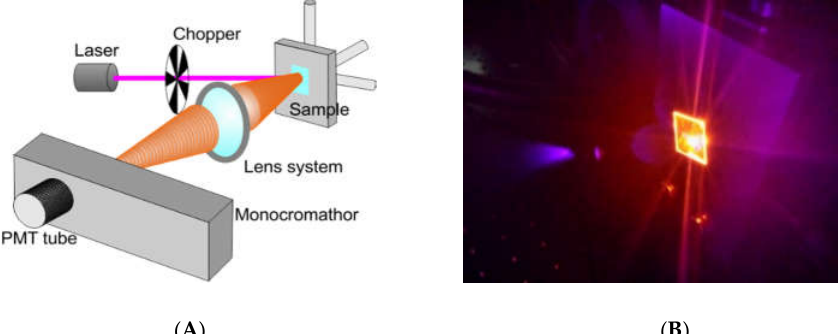
Figure 2. ( A ) Optical sensing system used for intracellular Ru(bpy) 32+ labeling analysis. ( B ) Detail of holder containing labeled HDFs sample.